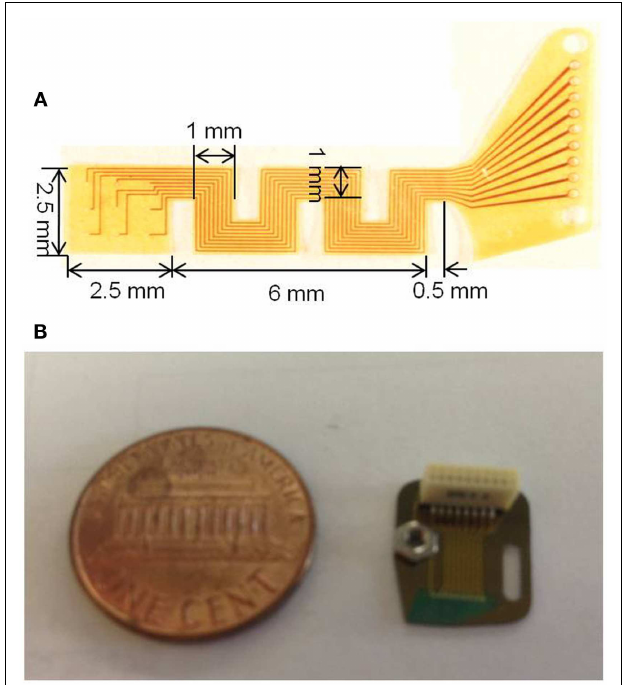
FIGURE 4 | (A) Photograph of the micro-fabricated serpentine polyimide cable prior to the attachment of the tungsten microwires and (B) photograph showing the fabricated silicon rigid module packaged with the Omnetics connector and the ground screw compared against a one cent